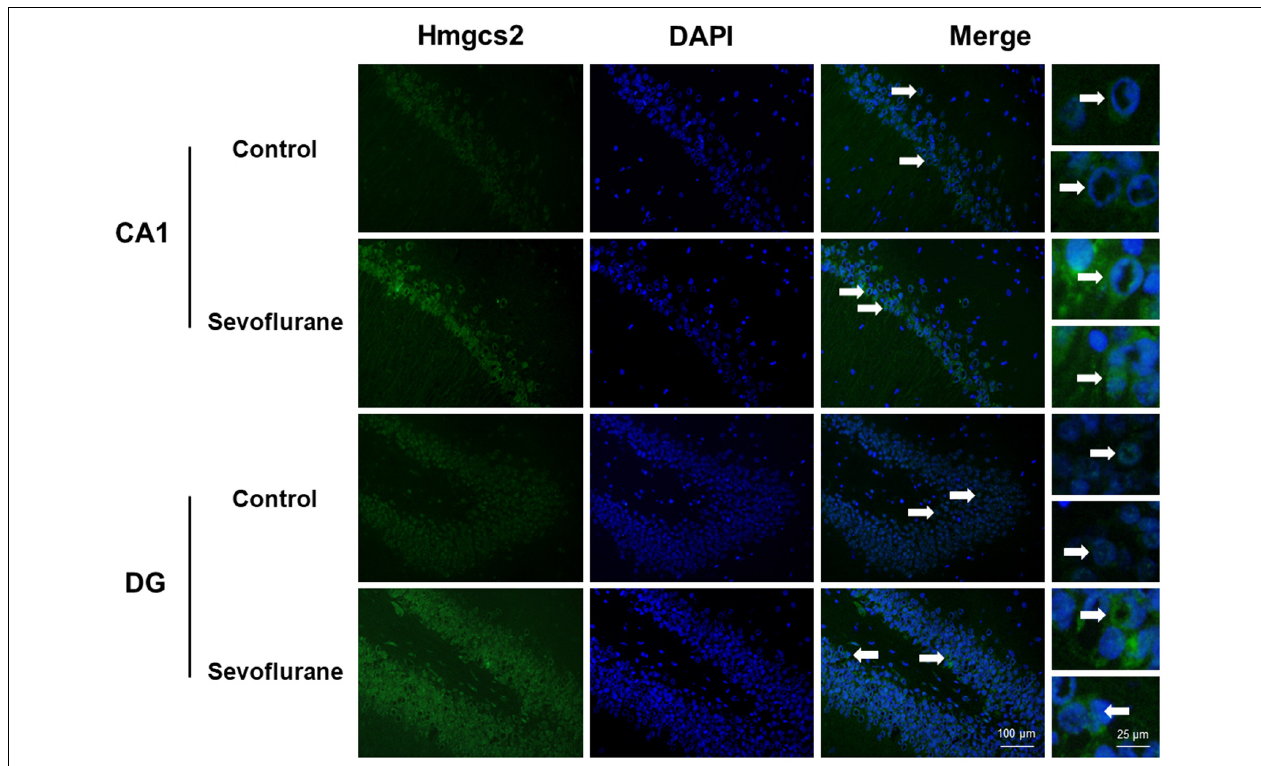
FIGURE 7 | Immunofluorescent staining of hippocampal Hmgcs2 in the CA1 region and DG region. Immunofluorescence images show RelA (FITC, green) and DAPI (blue) counterstain. In the control condition, the staining intensity of RelA in the cytosol of the pyramidal cell layer, CA1 region and the cytosol of the granular cell layer, DG region are weak. Six hours after exposure, the staining intensity of RelA in the cytosol of cells in both the CA1 region and the DG region is obviously increased. Arrows point to the typical RelA distribution, which are provided as high magnification images. Magnification 400 × , scale bar 100 and 25 µ